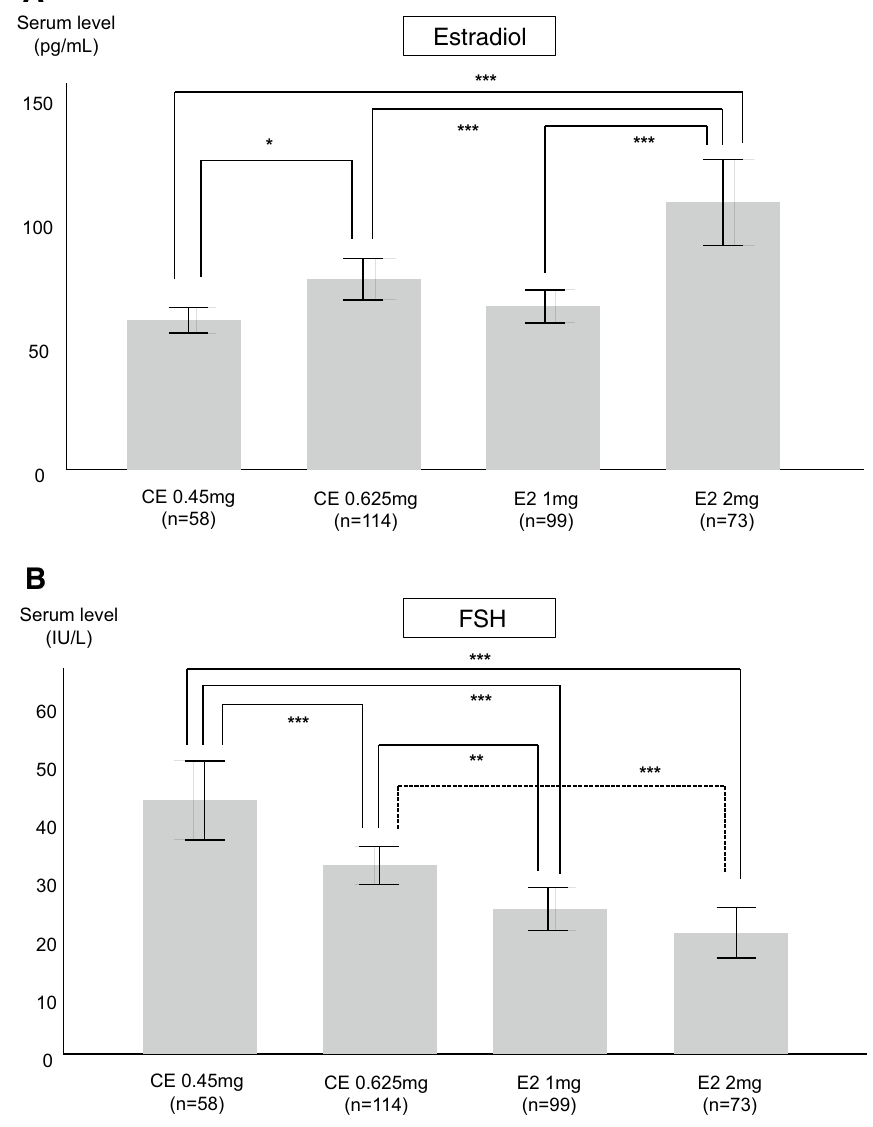
Figure 1. Comparisons of ( A ) serum estradiol and ( B ) serum follicle-stimulating hormone (FSH) levels according to doses and formulations of estrogens. *P < 0.05, **P < 0.01, and ***P < 0.001, using the analysis of variance followed by least significant difference post hoc